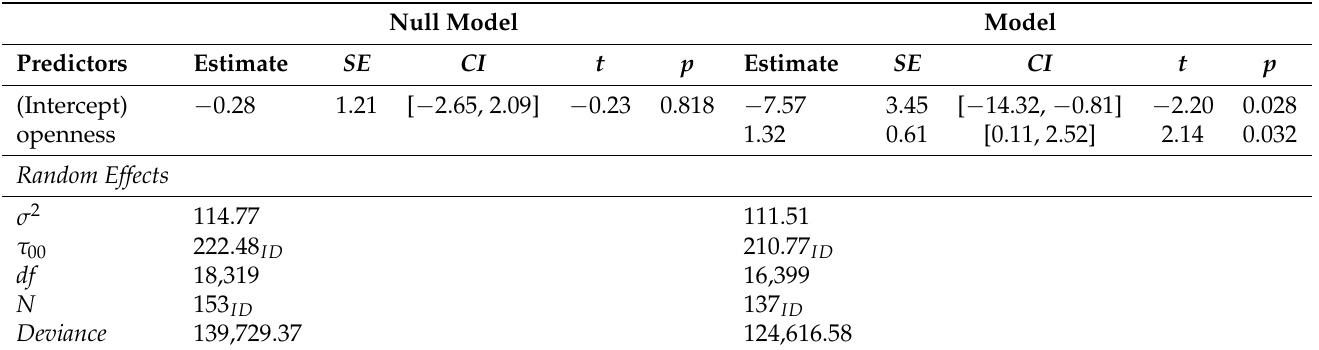
Table A18. Mixed model of the influence of openness on the HR.